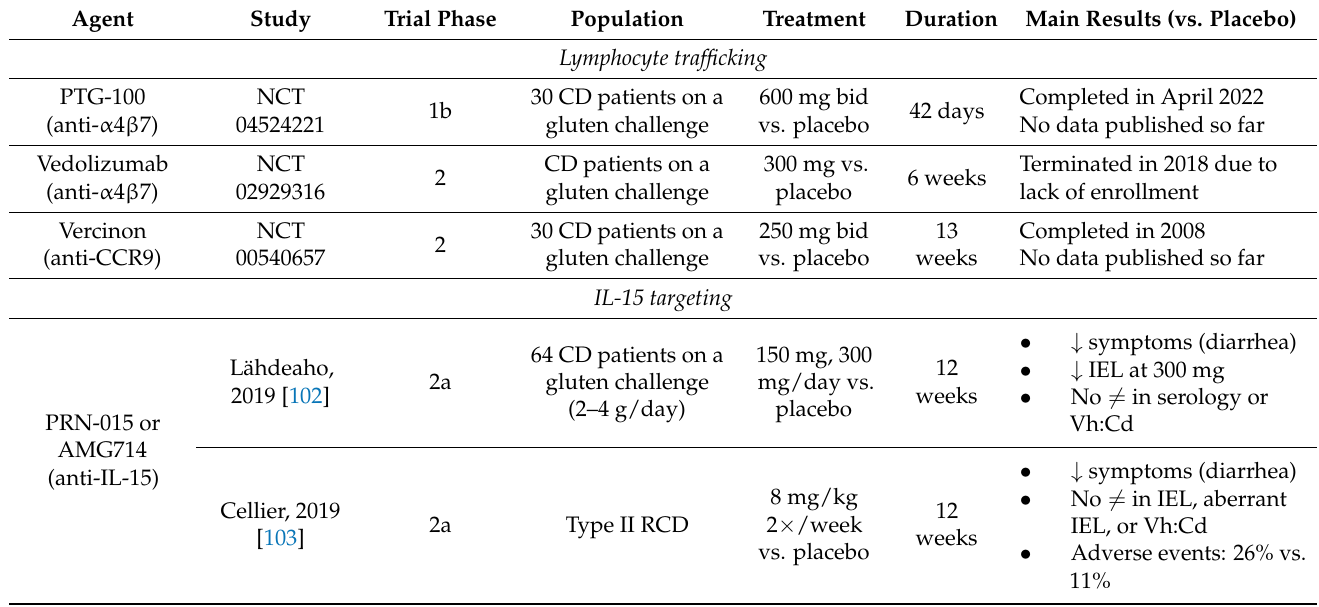
Table 2. Relevant clinical trials on agents that induce immune